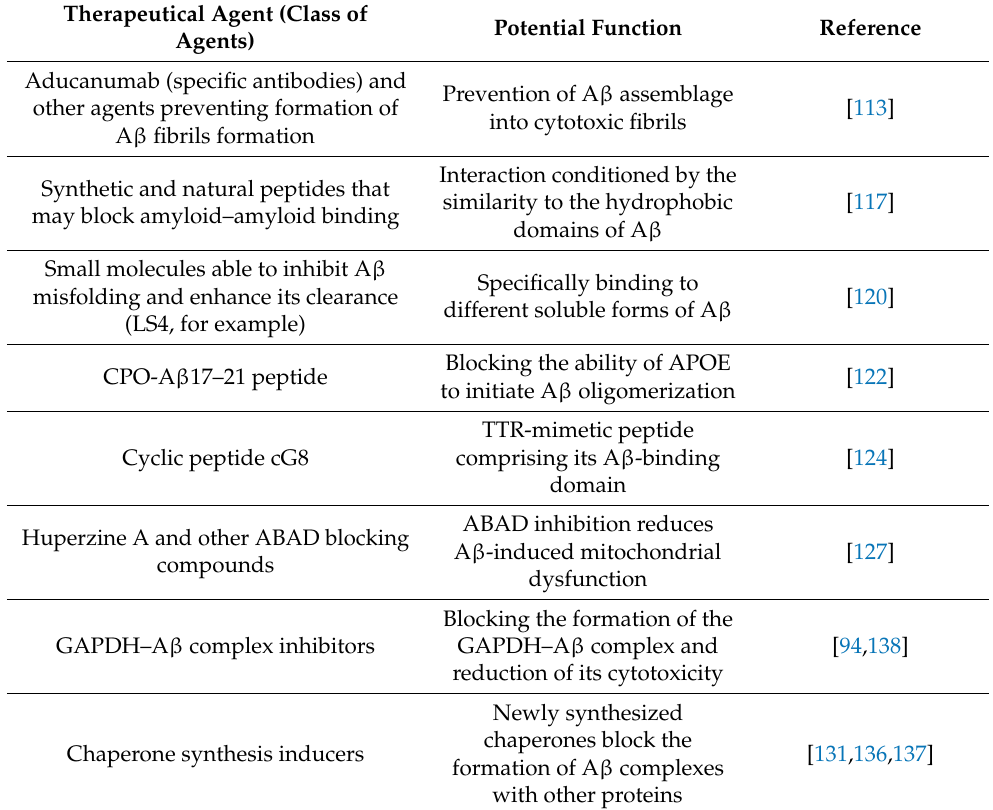
Table 2. Therapeutical agents with action based on prevention of A β -containing pathological com- plexes